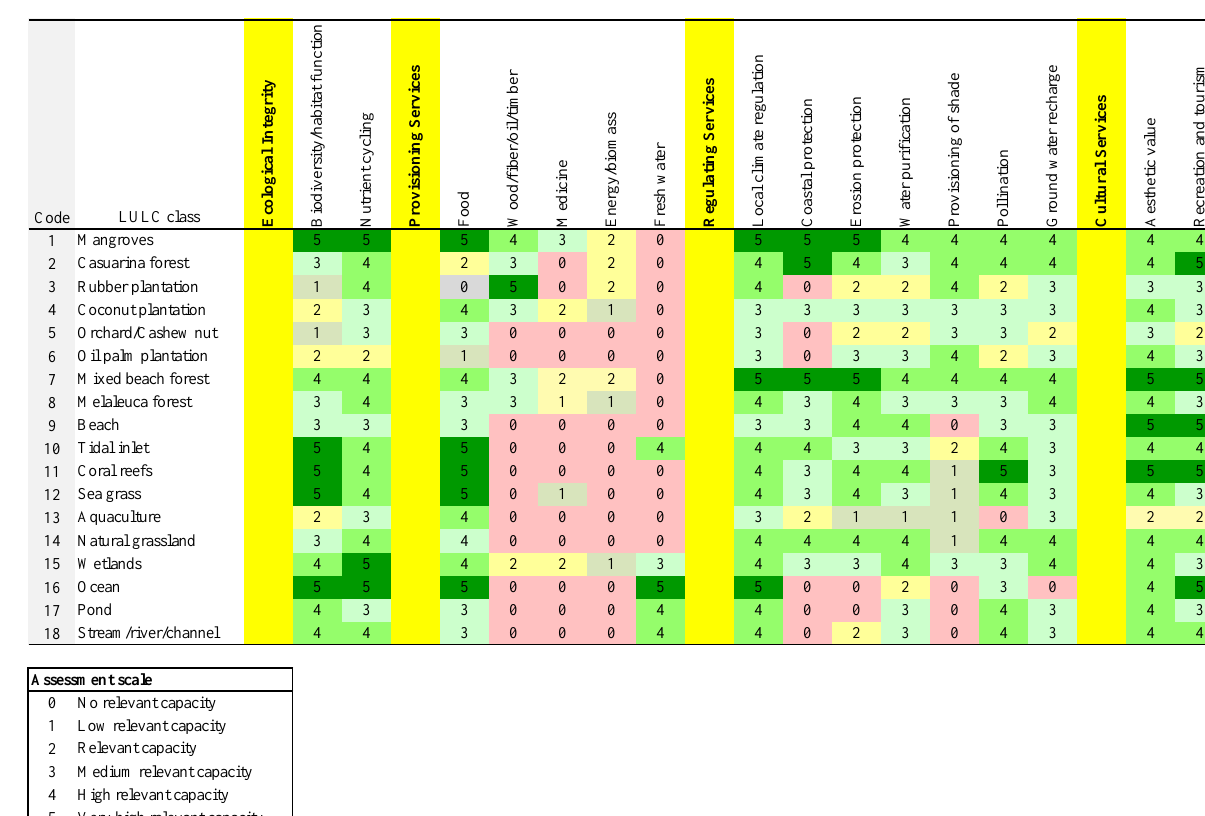
Table 2. Ecosystem services matrix for the coastal areas of the Phang Nga province, Thailand linking LULC classes to their capacities to support ecosystem functions and to supply ecosystem services on the scale: 0=no relevant capacity, 1=low relevant capacity, 2=relevant capacity, 3=medium relevant capacity, 4=high relevant capacity, 5=very high relevant capacity.